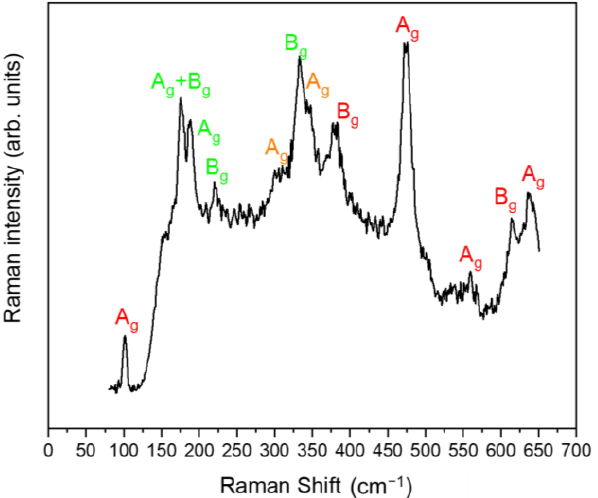
Figure 4. Typical Raman spectrum obtained from the samples. Colored labels: red, O-O bonds; green, Zr-Zr bonds; orange, Zr-O bonds.